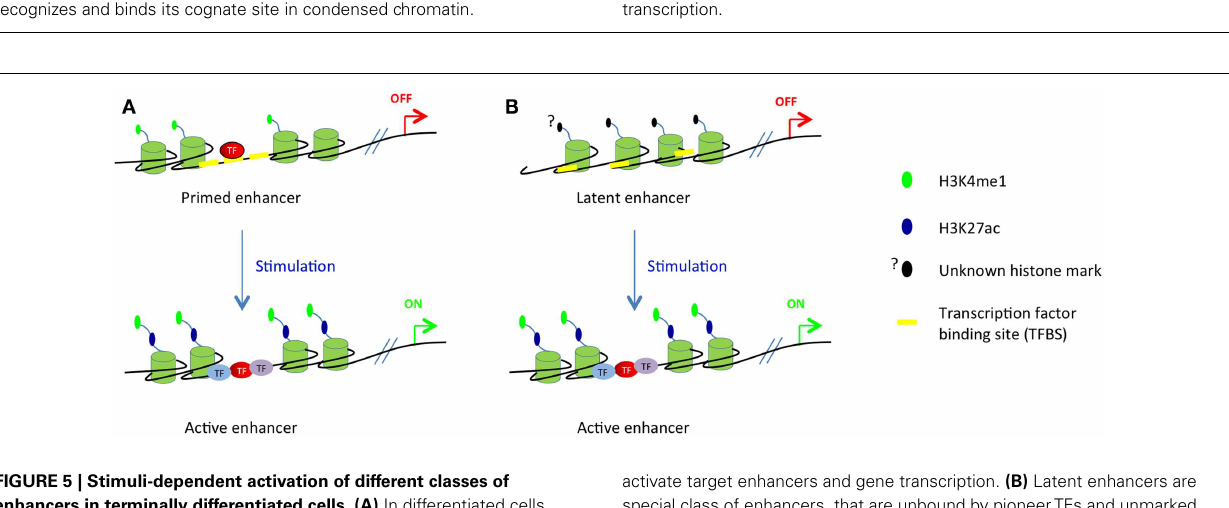
FIGURE 4 | Simplified scheme of stepwise enhancer activation based on the pioneering model. A pioneerTF is exemplified by the ETS factor PU.1; the transcription start site (TSS) is indicated by a red or green arrow and the enhancer element is schematized by four nucleosomes. For simplicity, the nucleosomes covering the rest of the DNA including the promoter region are not indicated. (A) The pioneerTF recognizes and binds its cognate site in condensed chromatin.